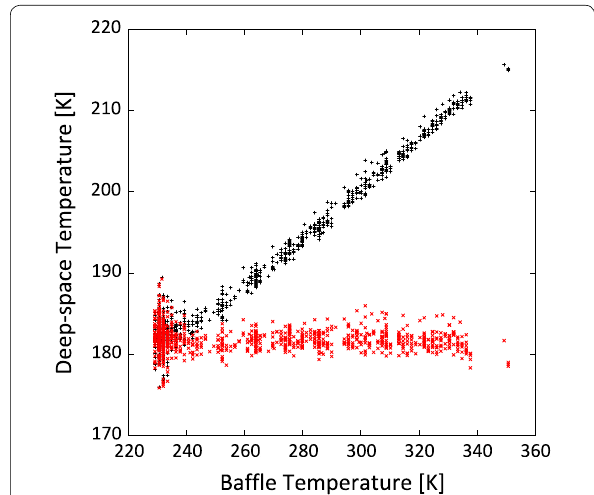
Fig. 6 Temperature distributions of deep space as a function of the baffle temperature. The distribution after correction of the back‑ ground bias is over plotted to that shown in Fig. 3b. Black and red dots show the distributions before and after correction,